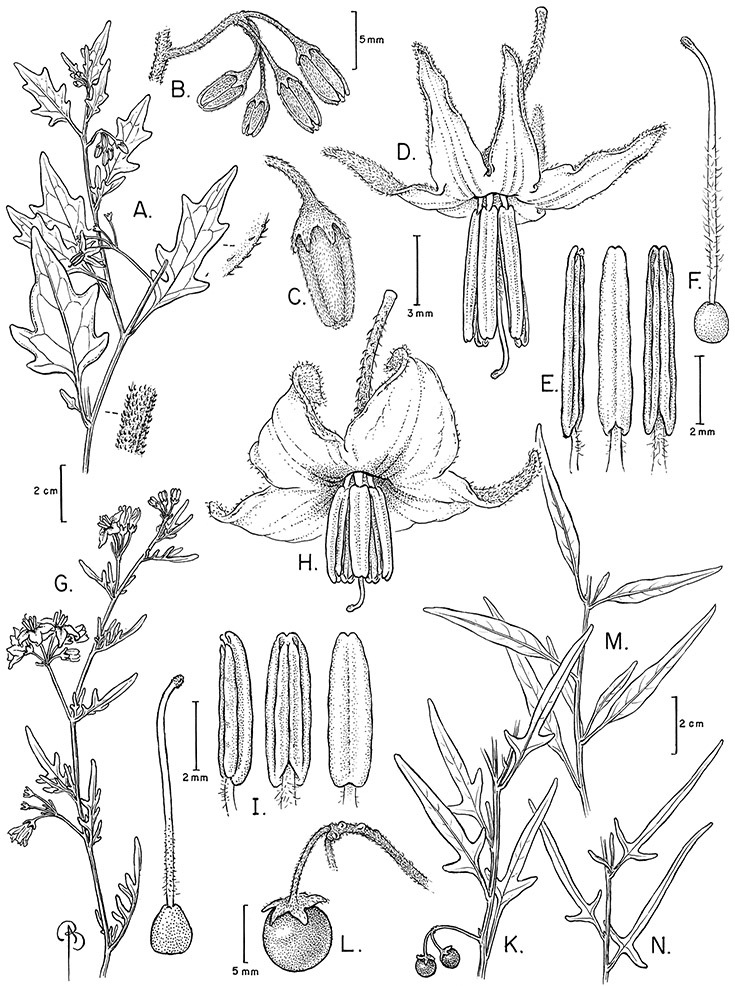
Solanum salicifolium Phil. (A–F drawn from Varela 633
G–J drawn from Keisling 7929
K–L drawn from Kuntze s.n., Dec 1891 M drawn from King 151
N drawn from Hieronymus s.n., coll. 1878). Illustration by Bobbi Angell.